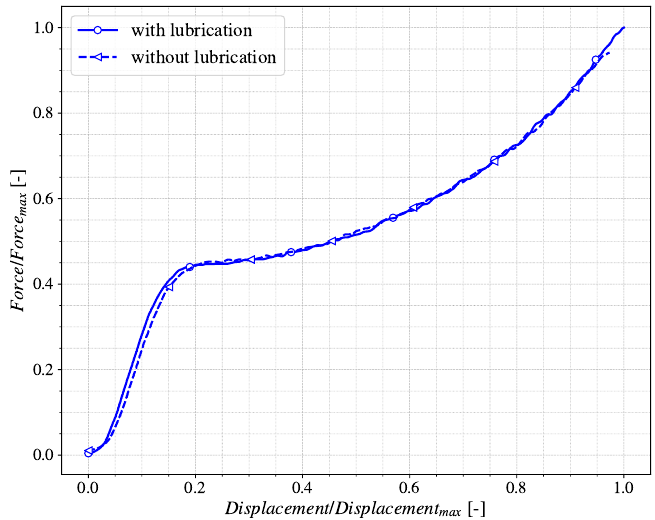
Figure 4. Lubrication effect on cylindrical samples in compression